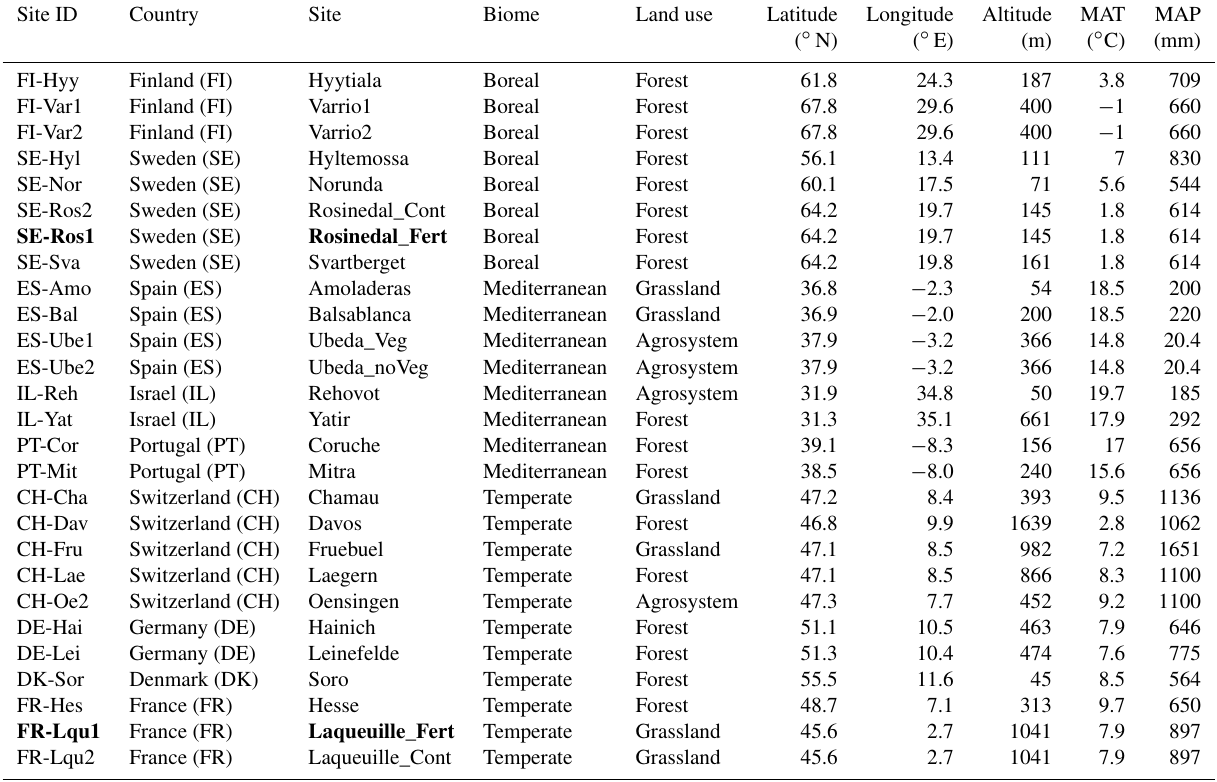
Table 1. Locations, names, climatic descriptions and land use characteristics of sites sampled across Europe and Israel. The two names in bold represent the two fertilised parcels in manipulation field experiments. Ubeda_Veg and Ubeda_noVeg represent soils sampled in the same location but with or without vegetation, respectively. Altitude, mean annual temperature (MAT) and precipitation (MAP) are estimated from the